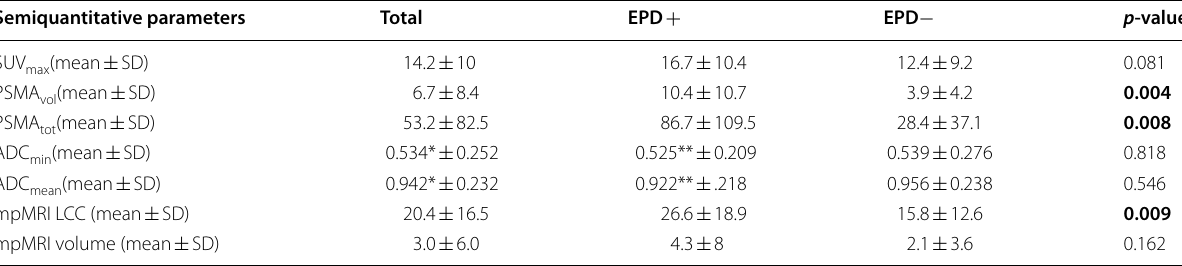
Statistically significant p -values are marked by bold font EPD extraprostatic disease, SUV standardized uptake value, max maximum, min minimum, SD standard deviation, ADC apparent diffusion coefficient, LCC longest capsular contact *72/73 patients assessable **30/31 patients assessable